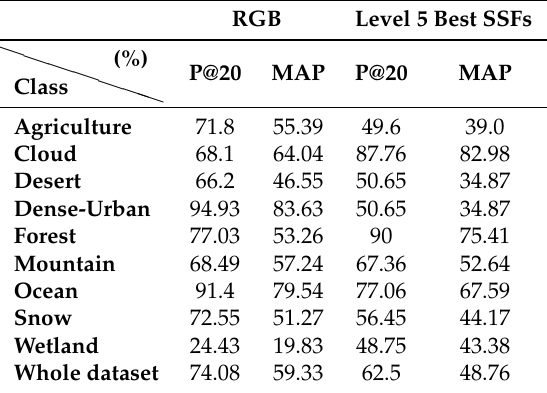
Table 2. RGB image retrieval results (Baseline) compared to level 5 best SSFs by category. RGB Level 5 Best SSFs (cid:80) (cid:80) (cid:80) (cid:80) (%) (cid:80) (cid:80)(cid:80) Class